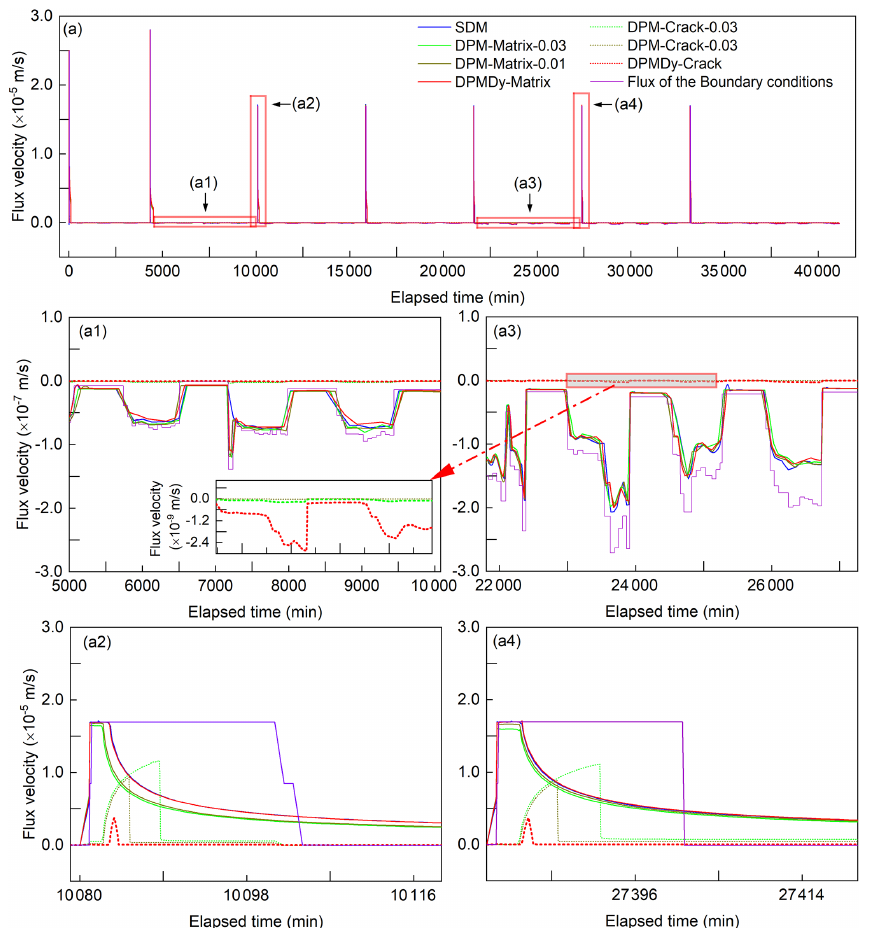
Figure 13. Boundary flow simulated by the SDM, DPM and DPMDy. (a) Flow velocity of the boundary conditions and simulated results; (a1) and (a2) are the enlarged images of the flow velocity during the second drying and third wetting process, respectively; (a3) and (a4) are the enlarged images of the flow velocity during the fifth drying and sixth wetting process, respectively. The positive value is for infiltration and negative for evaporation.